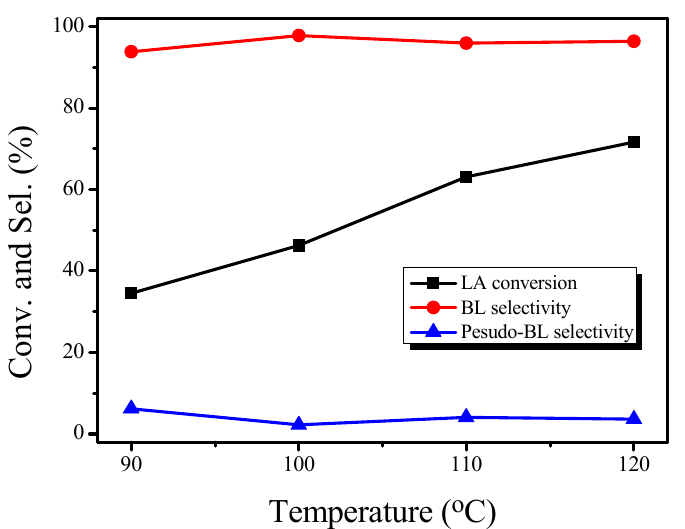
Figure 6. Influence of the reaction temperature on the esterification of LA. Reaction conditions: LA: n-butanol = 1:10, catalyst loading: 10 wt.% (based on the LA mass), and reaction time: 6 h.